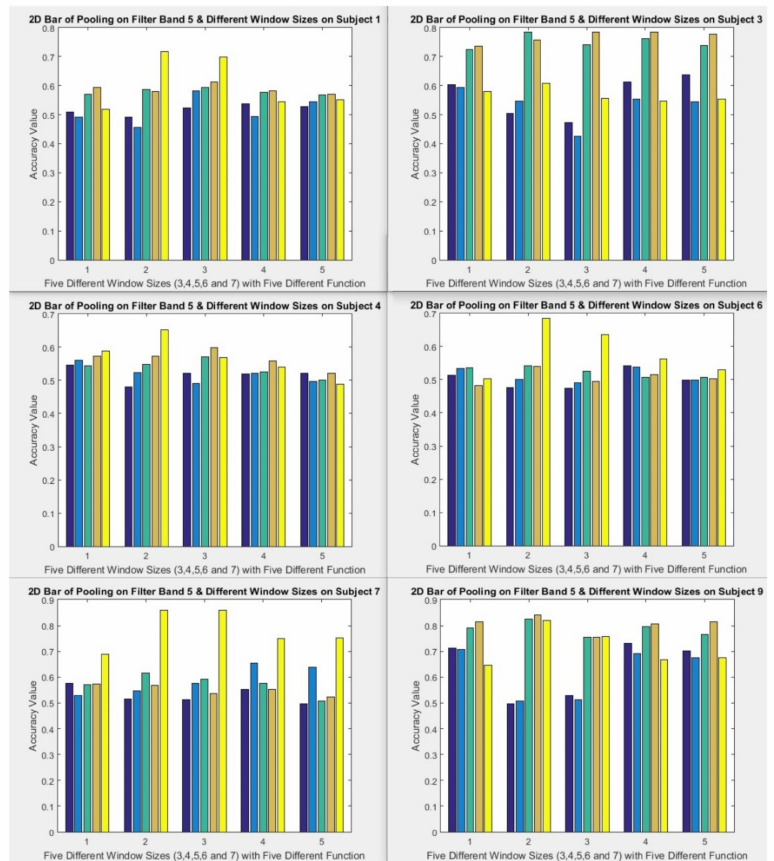
Figure 10. Reduction data based on pooling model on some subjects (1, 3, 4, 6, 7, 9) and filter banks with different window sizes for FB 5 and RF for 10 iterations.